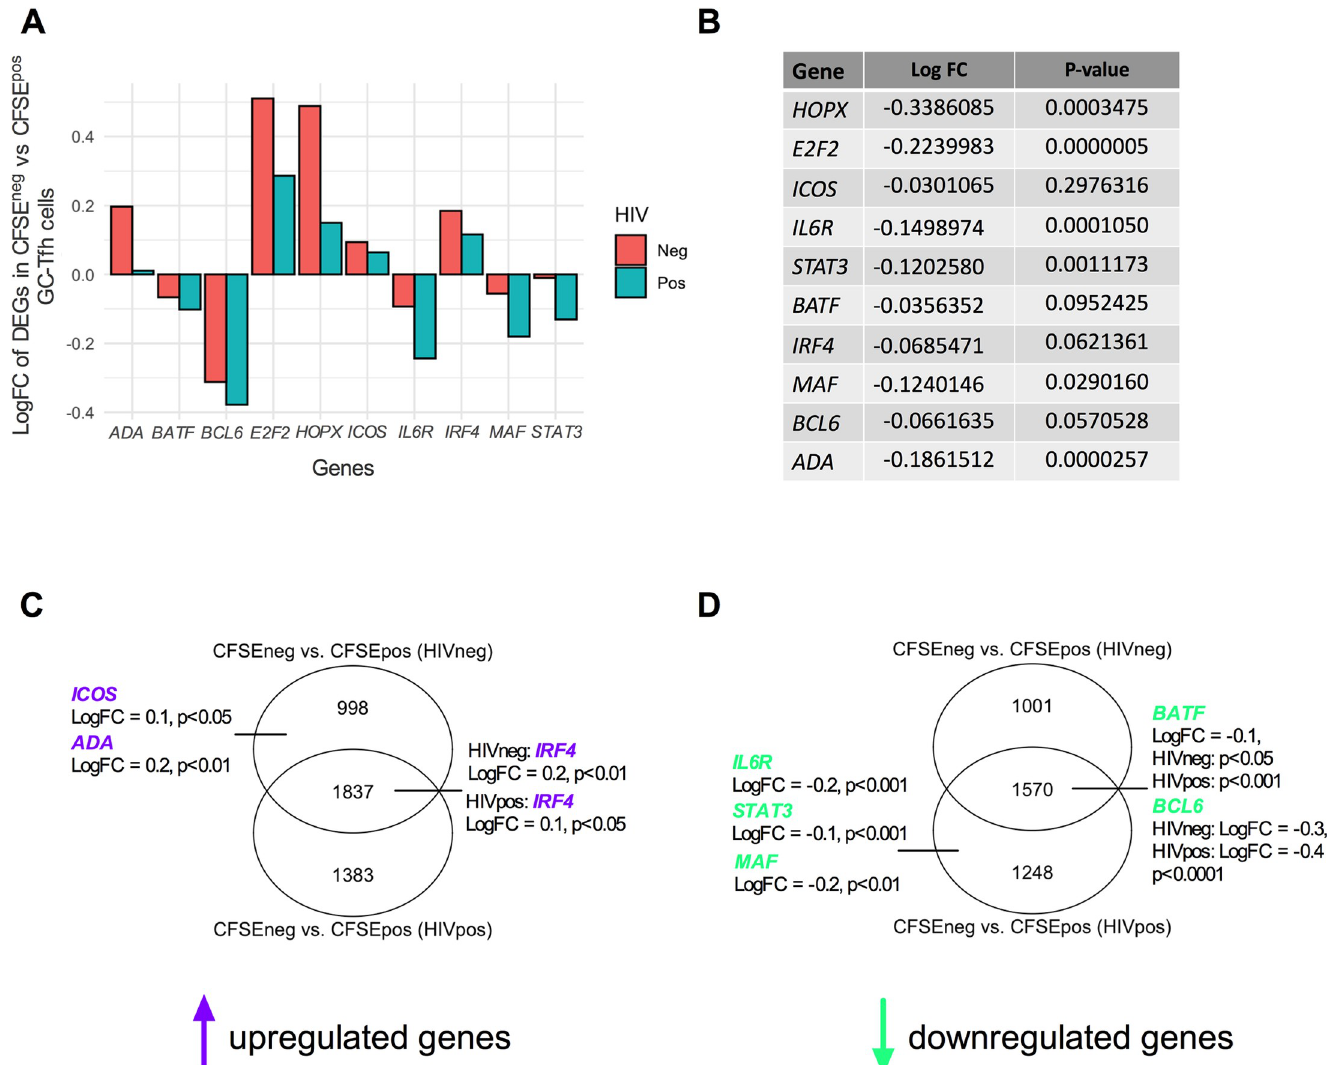
Fig 5. c-Maf signaling represents a key dysregulated pathway in proliferating HIV pos GC-Tfh cells. (A) shows log2-fold change (logFC) in the expression of selected DEGs in different cell signaling and GC-Tfh-associated immunological pathways in proliferating (CFSE neg vs CFSE pos ) HIV neg and HIV pos GC-Tfh cells. Among these, are genes coding for transcription factors ( E2F2 ) and coregulators ( HOPX ), enzymes ( ADA ) and key GC-Tfh genes ( ICOS , IRF4 , BCL6 , MAF and mediators of its signaling pathway IL6R , STAT3 , BATF ). (B) table showing log2-fold change (logFC) values and statistical significance between proliferating HIV pos versus HIV neg GC-Tfh cells for each selected DEG in (A). To assess statistical significance between the logFC of proliferating HIV pos versus HIV neg GC-Tfh cells, data in (A) was analyzed using a double contrast. CFSE neg values were baselined to CFSE pos values and an HIV pos versus HIV neg contrast was performed to compare significance between (CFSE neg vs CFSE pos ) HIV pos and (CFSE neg vs CFSE pos ) HIV neg cells. (C-D) Venn diagram analysis of proliferating (CFSE neg vs CFSE pos ) HIV neg and HIV pos GC-Tfh cells. Diagrams show the numbers of unique and common statistically significant DEGs in the indicated GC-Tfh populations. (C) shows Venn diagram analysis of upregulated DEGs (represented in purple) and (D) shows Venn diagram analysis of downregulated DEGs (represented in green) in HIV neg and HIV pos cells. (B-D) Analysis was performed based on nominal p-value p < 0.05.